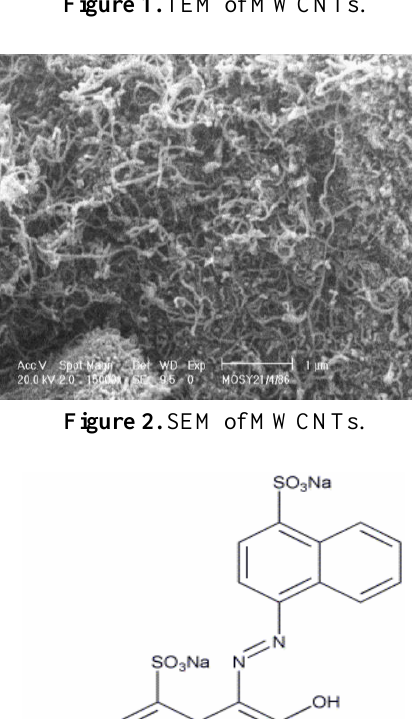
Figure 1. TEM of MWCNTs.